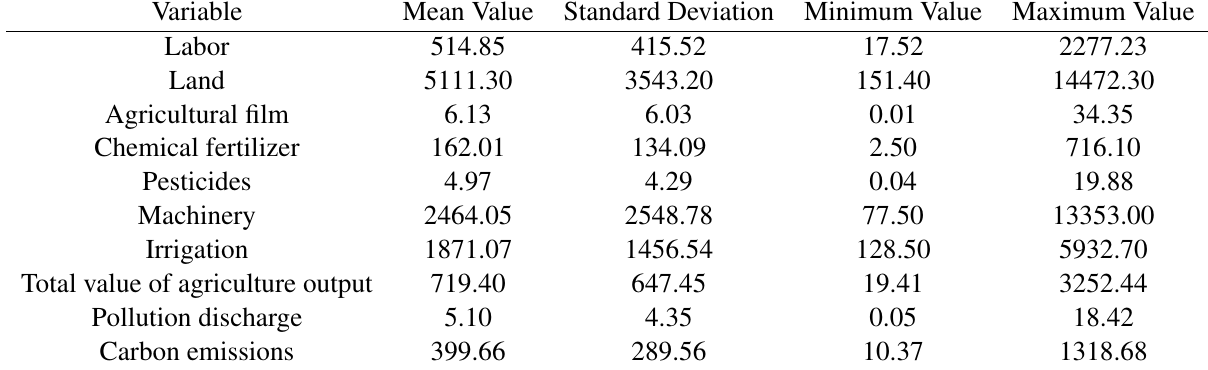
Table 2 Descriptive statistics for agricultural GTFP evaluation indexes from 1997 to 2016.